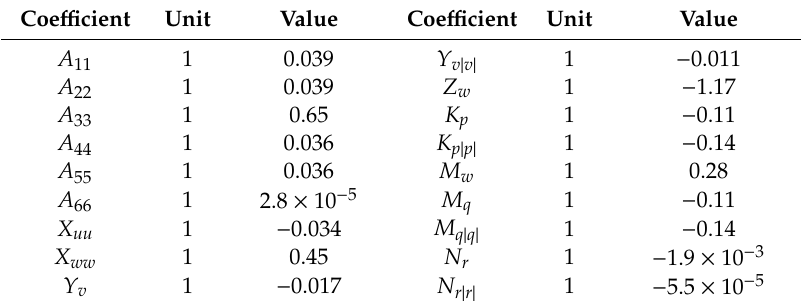
Table 3. Dimensionless coe ffi cients of the